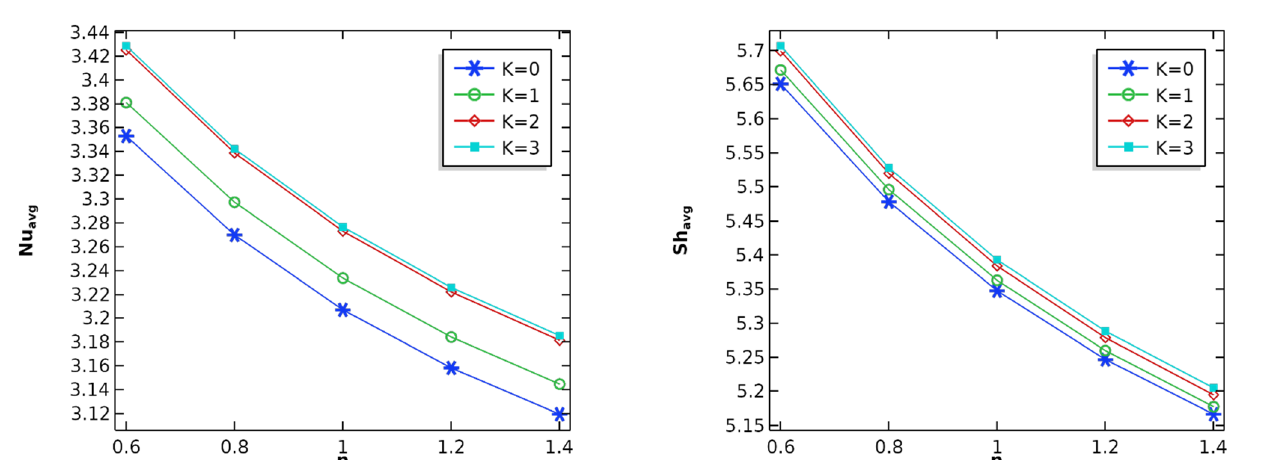
Figure 15. Impact of average Nu and Sh .